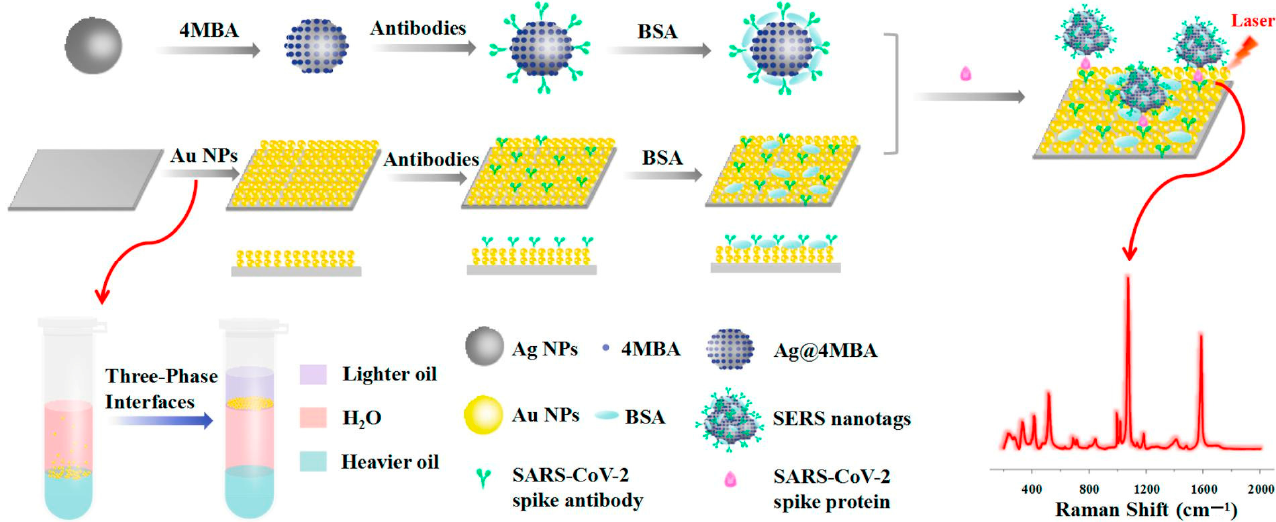
Figure 19. SERS-based immunosensor for SARS-CoV-2 detection in saliva. A two-layer AuNPs functionalized with antibodies on silicon wafers are sandwiched using AgNPs conjugated with secondary antibodies upon interaction with the viral particles. Upon detection of the analyte, the coupling between AgNPs and AuNPs increases the light scattered through plasmonic behavior. Image adapted from [124] with permission of Elsevier, 2021.